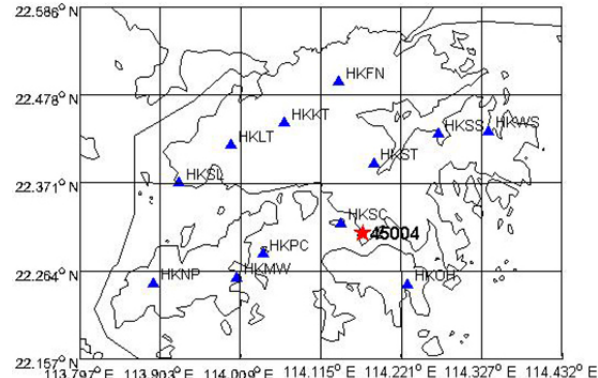
Figure 1. Distribution of the Hong Kong SatRef sites (blue trian- gle) inside the tomography grid (black line) and the KingPark ra- diosonde station (red pentagram). The region was discretized into a 6 × 4 × 16 cell grid for the water vapor tomography. Heights of layers are (0, 500, 800, 1200, 1600, 2000, 2500, ..., 9000, 10000m).